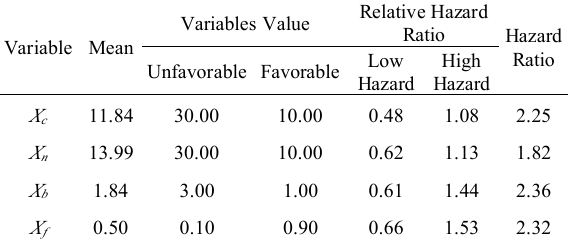
Table 2. Analysis of variables related to travel time.